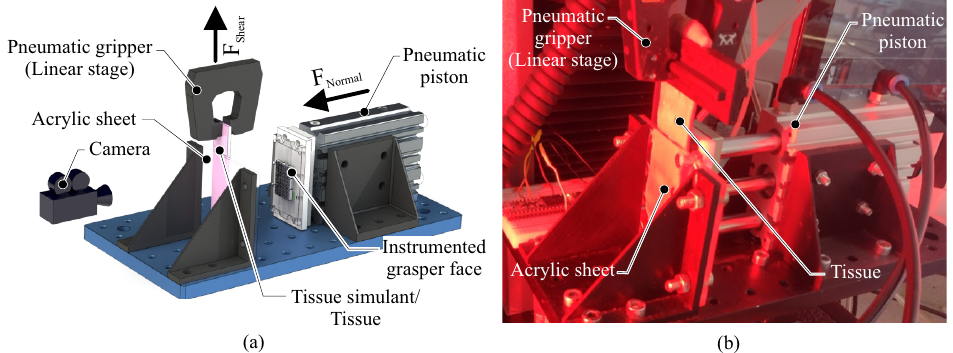
Figure 4. ( a ) A schematic showing the key components of the experimental system. ( b ) An image of the experimental system used for simulating surgical grasping and